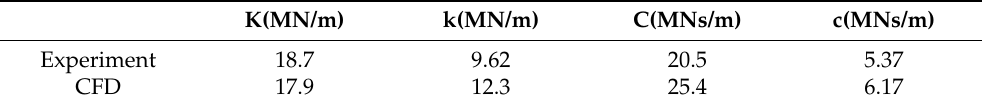
Figure 8. Tangential impedance ( a ) and radial impedance ( b ) curves for the annular seal. Table 4. Rotordynamic coefficients of experimental data and numerical